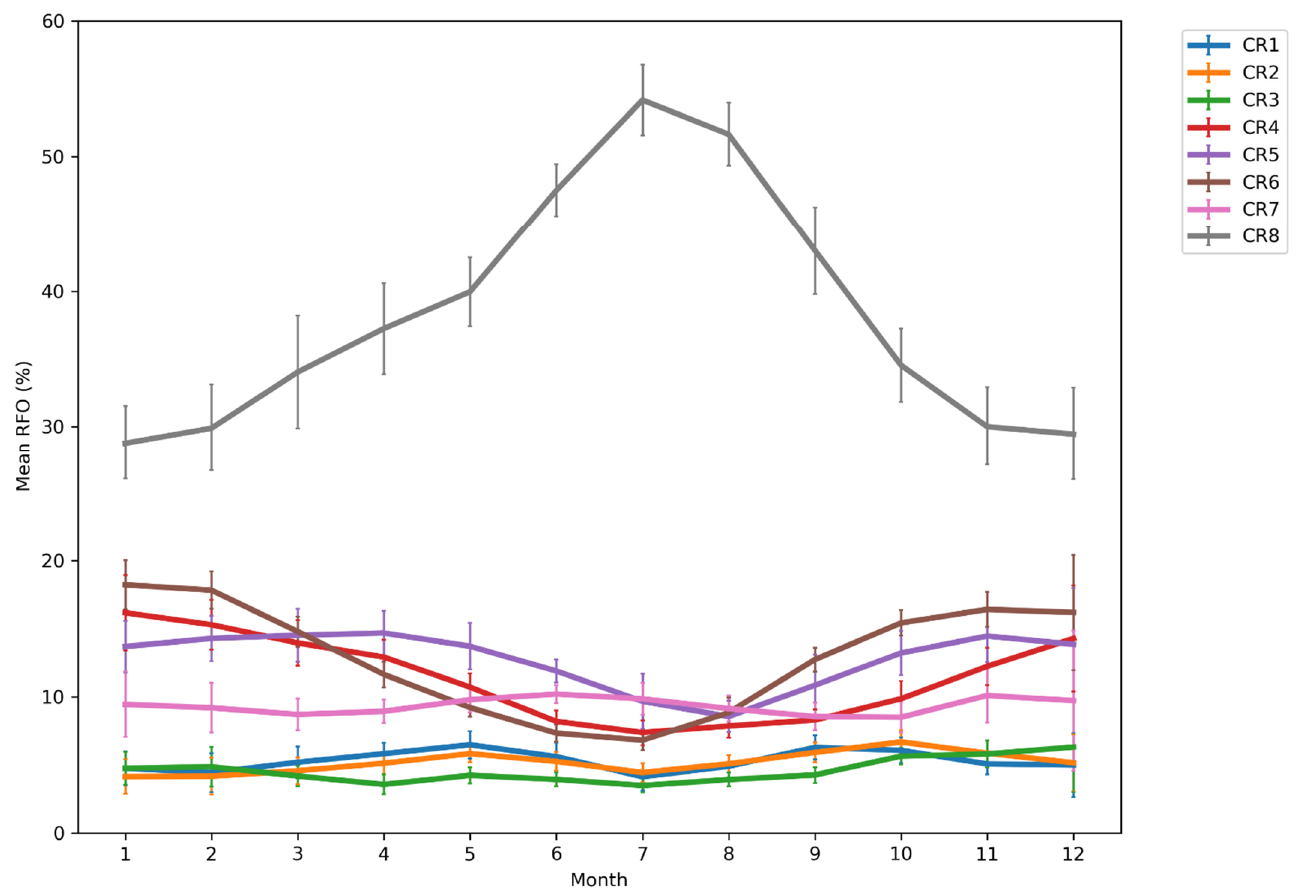
Figure 4. Mean intra-annual variability of the relative frequency of occurrence (RFO) of the 8 CRAAS cloud regimes (CRs) over Europe for the 2004–2017 period.